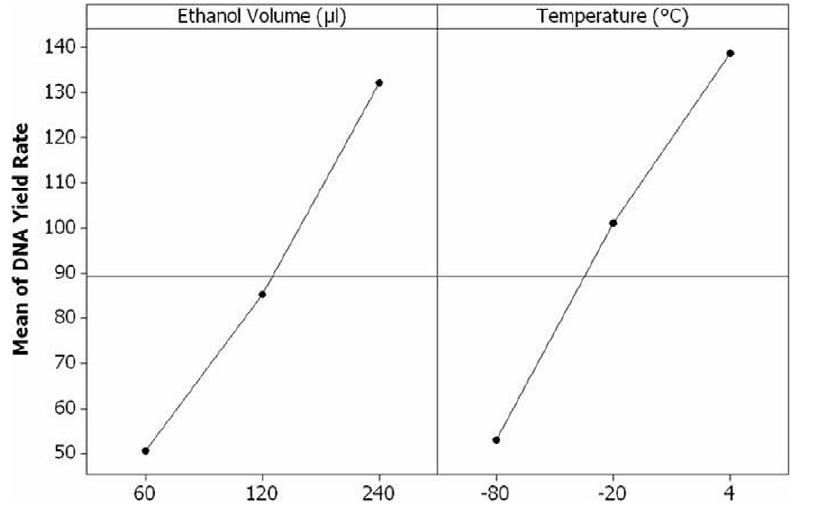
Figure 2. Main effects plot of ethanol volume and temperature on DNA yield rate resulted from precipitation. The horizontal reference line is drawn at the overall mean of DNA yield rate. The dots display the response means for each factor level. The effects are the differences between the means and the reference line.